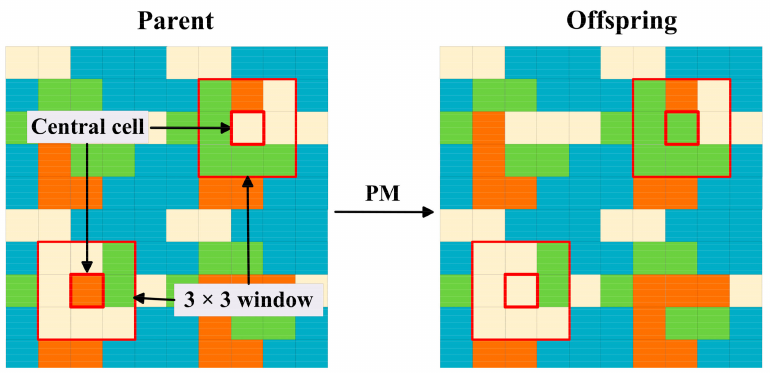
Figure 5. Procedure of Point-based Mutation (PM) where the center cell within a 3 × 3 window in the parent is replaced by the most numerous